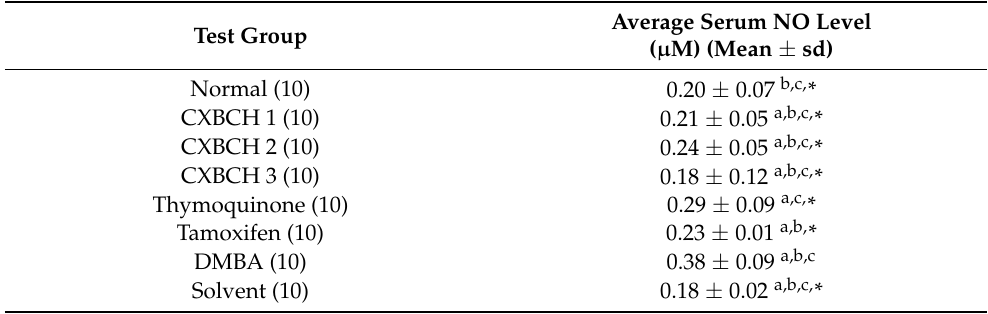
Table 6. Serum NO levels in SD rats treated with CXBCH two weeks prior to and five weeks during DMBA induction at week 30.